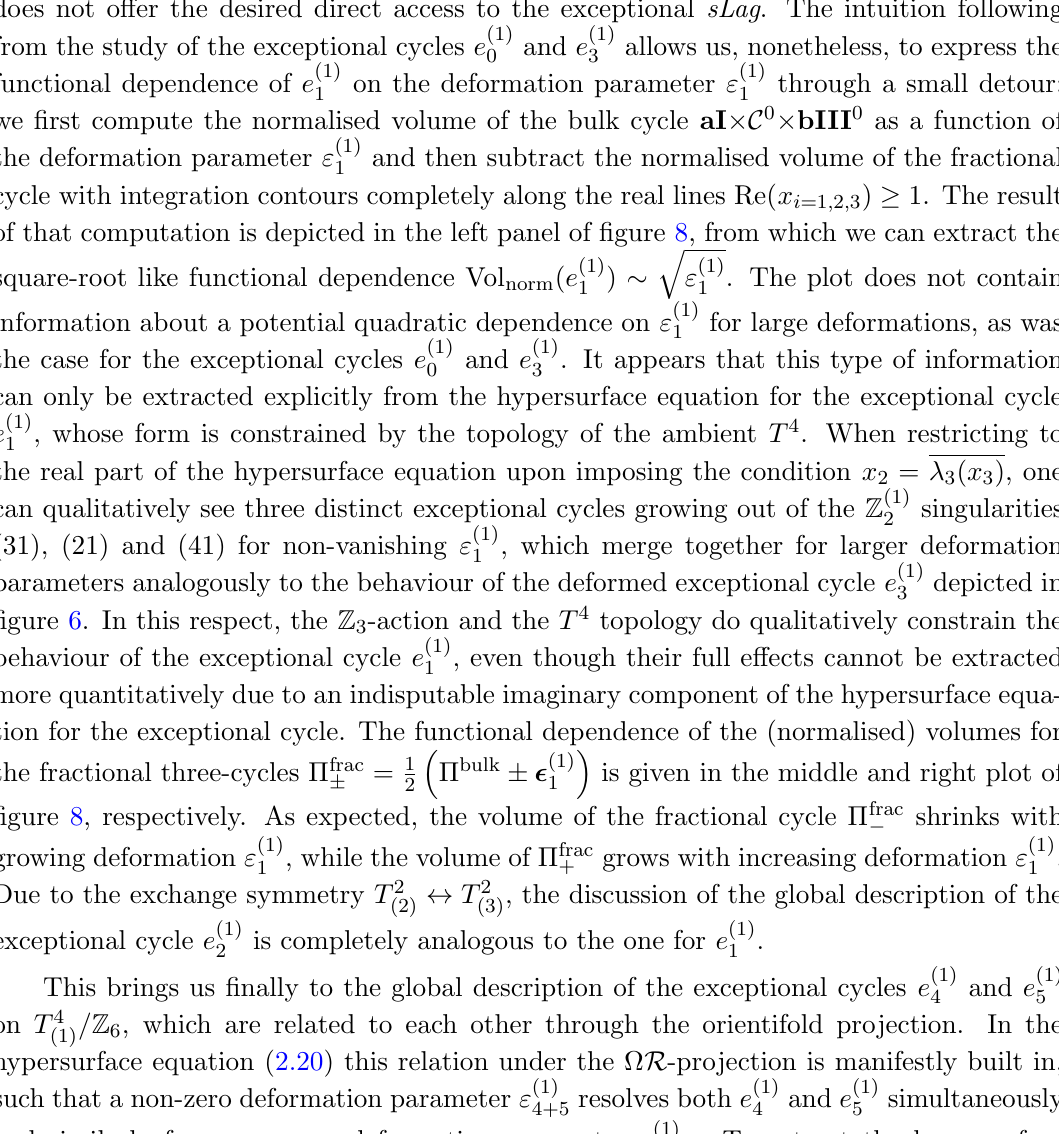
Figure 8 . Normalised volume of (one S 2 in) the resolved exceptional cycle e (1) fractional cycles (cid:5) frac